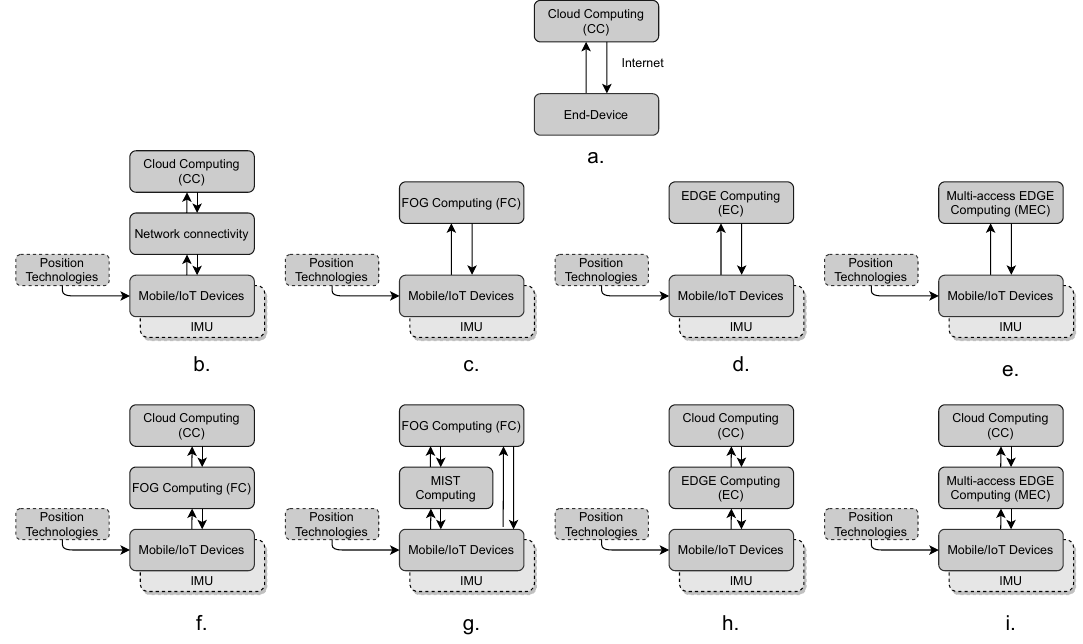
Figure 3. Current Cloud-based IPS/ILS architectures: ( a ) Cloud Computing (CC), ( b ) Mobile Cloud Computing (MCC), ( c ) Fog Computing (FC), ( d ) Edge Computing (EC), ( e ) Multi-access Edge Computing (MEC), ( f ) Mobile-Fog-Cloud, ( g ) Mobile-Mist-Fog, ( h ) Mobile-Edge-Cloud, ( i )